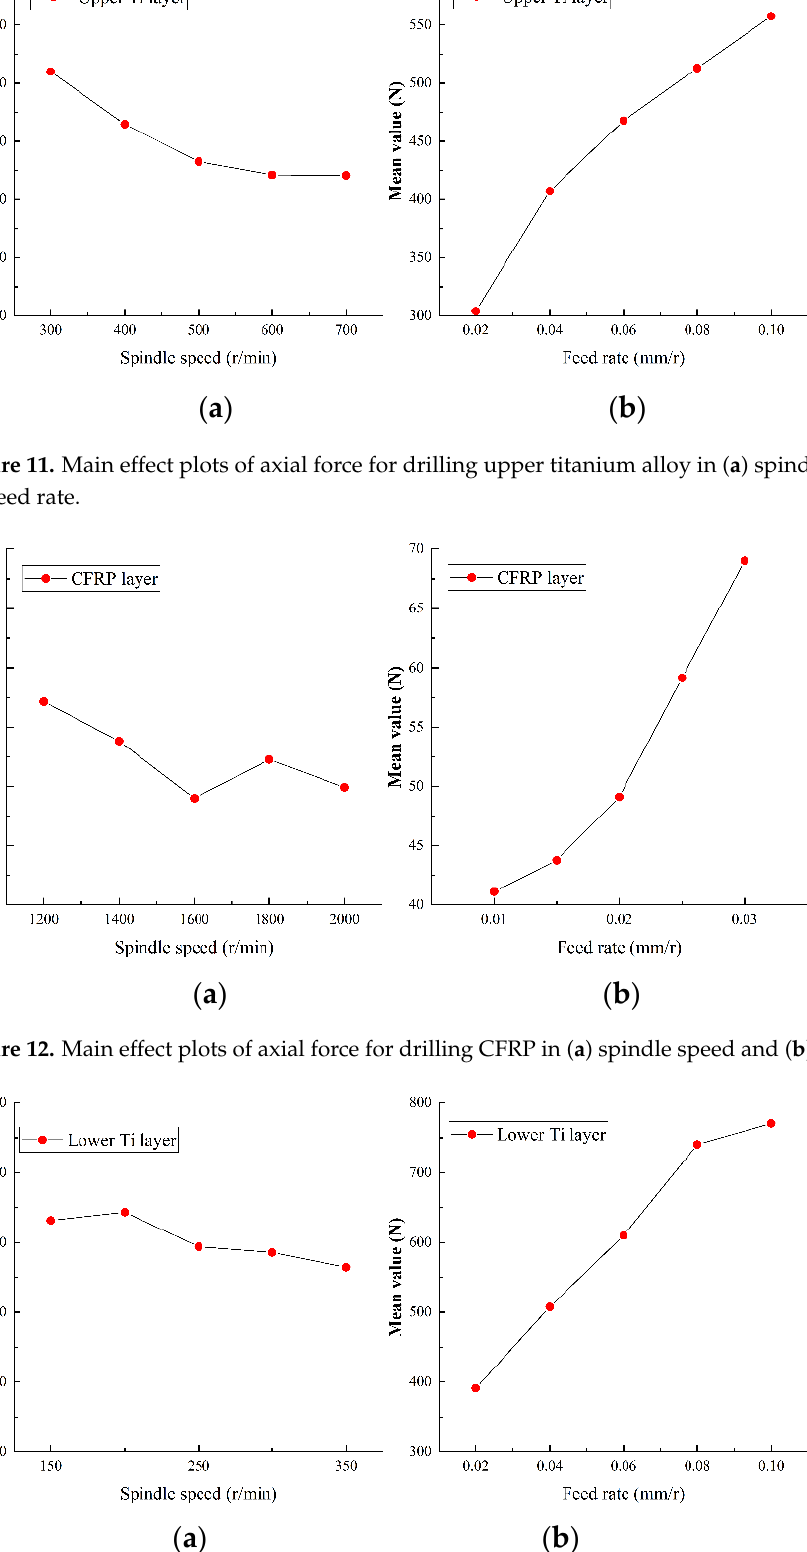
Figure 13. Main effect plots of axial force for drilling lower titanium alloy in ( a ) spindle speed and ( b ) feed rate.